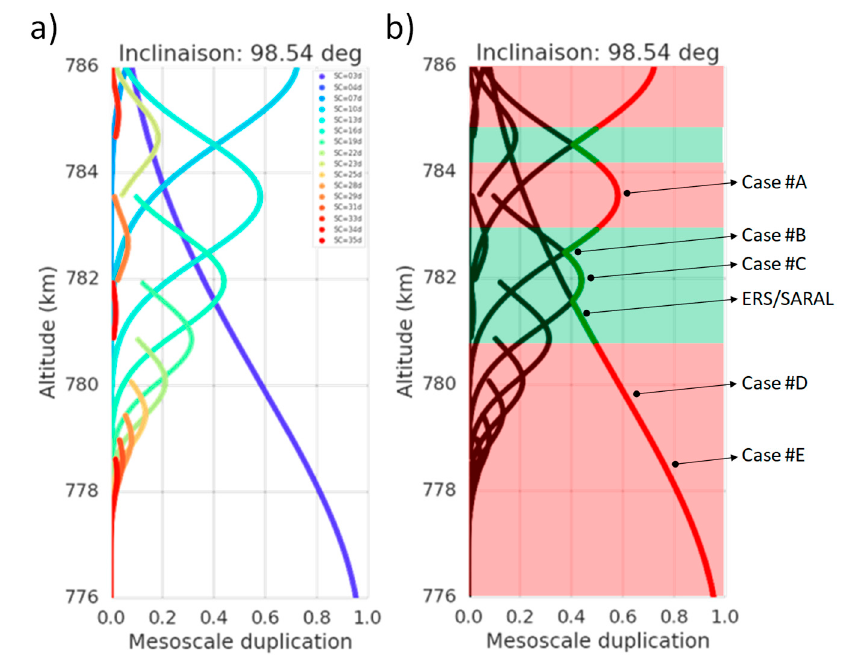
Figure 10. Quality of the mesoscale observation as a function of the altitude. For each altitude, we analyze the alignment of altimeter tracks in the space/time plane. Then we compute their correlation for ocean mesoscales. Each alignment is a sub-cycle and we can determine which sub-cycle contributes positively or negatively to the quality of mesoscale observation at this altitude (panel ( a )). In panel ( b ), we separate favorable (green) from undesirable (red) altitudes by looking at the maximal correlation of each orbit sub-cycle. This metric corresponds to the overlap between the grey circles in Figure 1. The 5 orbit cases shown in Figure 3 and the ERS/ENVISAT altitude are highlighted in panel ( b ).